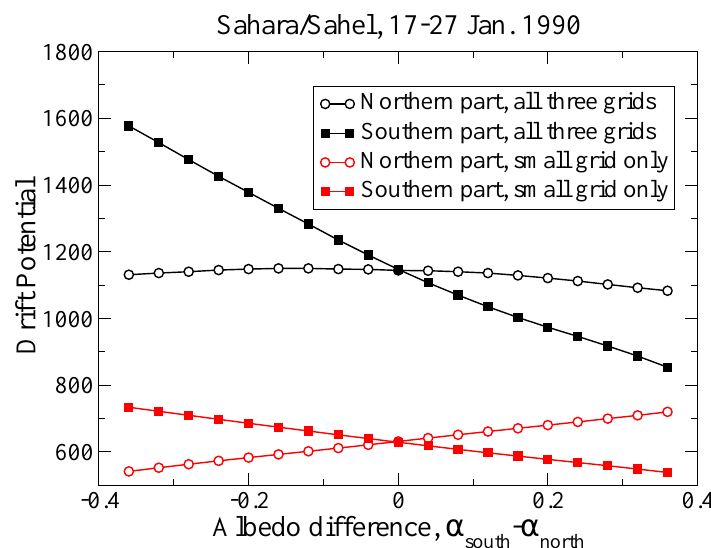
Figure 5. Wind drift potential (DP) as a function of the prescribed albedo difference between the southern (Sahel, squares) and northern (Sahara, circles) regions (Figure 1b), when the albedo was changed only within the innermost grid (red) and when the albedo was changed in all three grids (black).